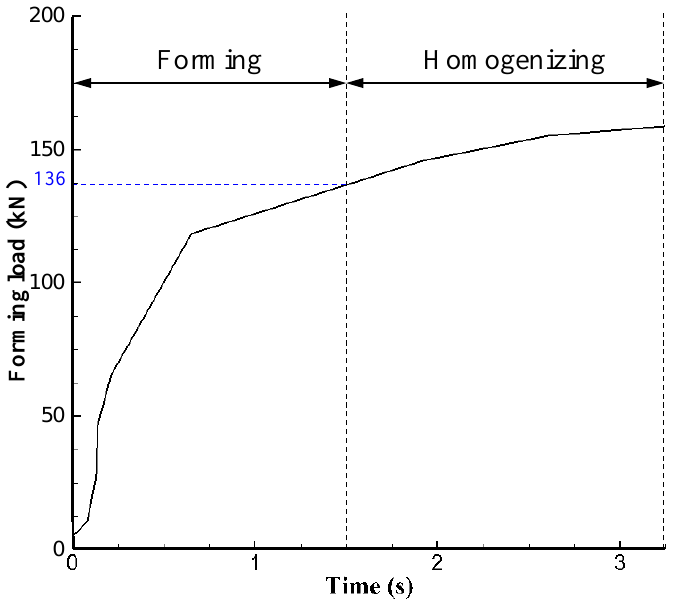
Figure 3. The input forming load – time curve.